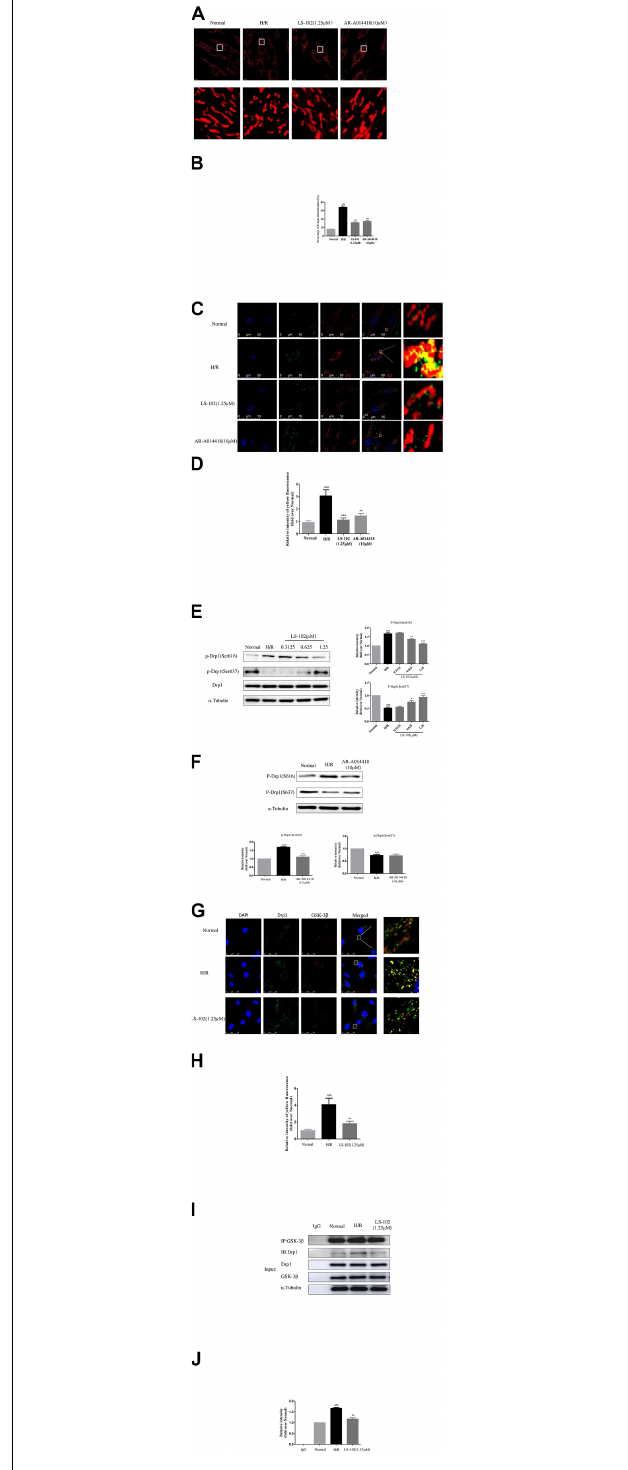
FIGURE 6 | Effects of LS-102 on Drp1-dependent mitochondrial fission induced by H/R in H9c2 cells. (A) Representative images showing MitoTracker Red CM-H2Ros staining (MitoROS; red) were captured by confocal microscopy with × 40 objective (Olympus). (B) Bar graph showing